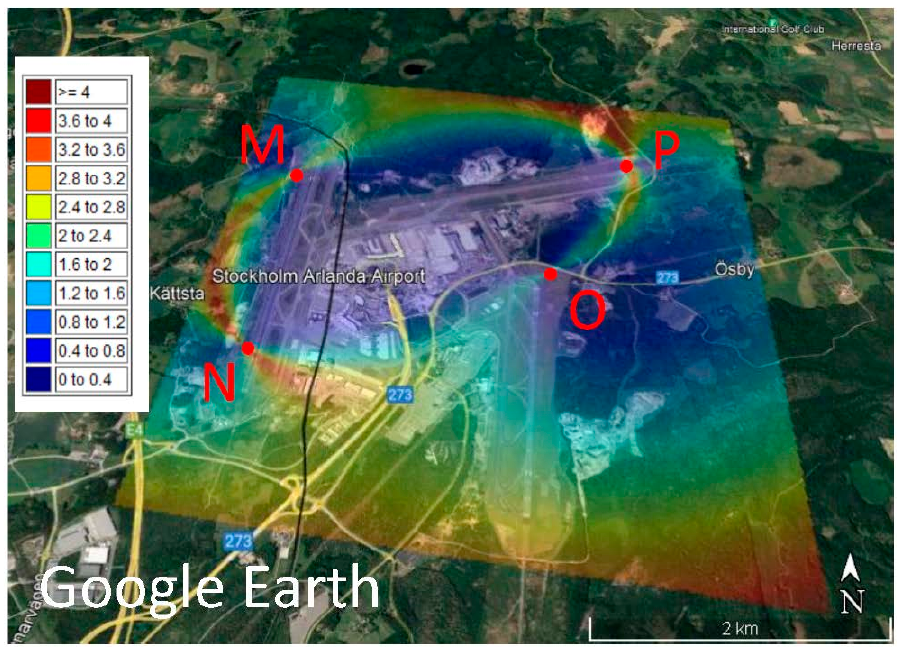
Figure 3. Dilution of precision (DOP) of the optimal design of a security localisation network with the variance-covariance matrix (VCM) criterion based on the received signal strength differences (RSSD) over the Google Earth map of the Arlanda international airport.